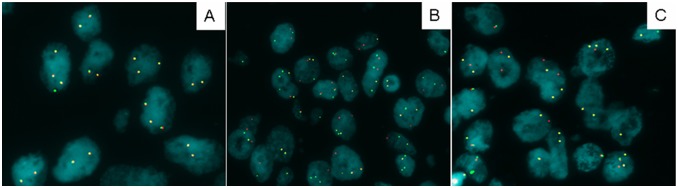
Detection of ALK rearrangements using Fluorescent in situ hybridization (FISH) (1000×).(A) An ALK-negative case. (B) An ALK-positive case with split signal pattern. (C) An ALK-positive case with isolated red signal pattern.